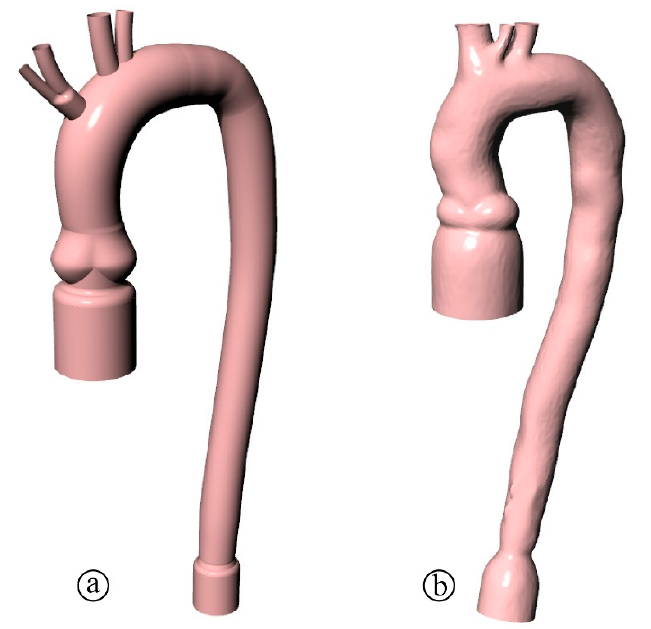
Figure 1. Anatomy of the phantoms: ( a ) parametrized and ( b ) patient specific aortic arch. Two constitutive models are adopted for vessel walls to perform FSI simulations and compare the effects of different mechanics on the